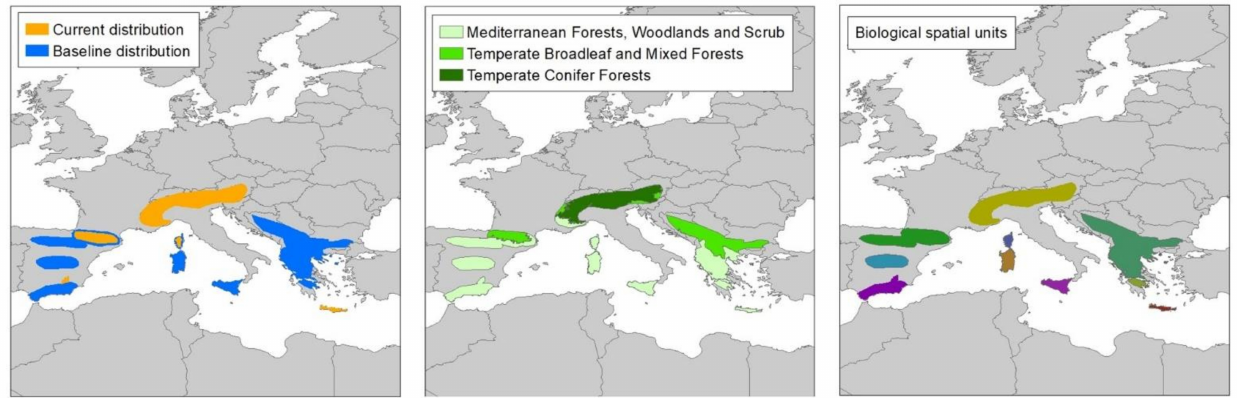
Figure 6. Spatial units based on biomes (coarse-scale) overestimate Green Score compared with bio- logically based spatial units for the bearded vulture Gypaetus barbatus . ( Left ): The current distribution covers less than half of the baseline distribution. Center : Dividing the baseline distribution by biome results in three spatial units, but these units are discontinuous (all areas with same color considered same spatial unit). The species is therefore considered Present in all three spatial units. ( Right ): Using biologically based spatial units results in 10 spatial units, none of which are discontinuous; the species is considered Present in half of